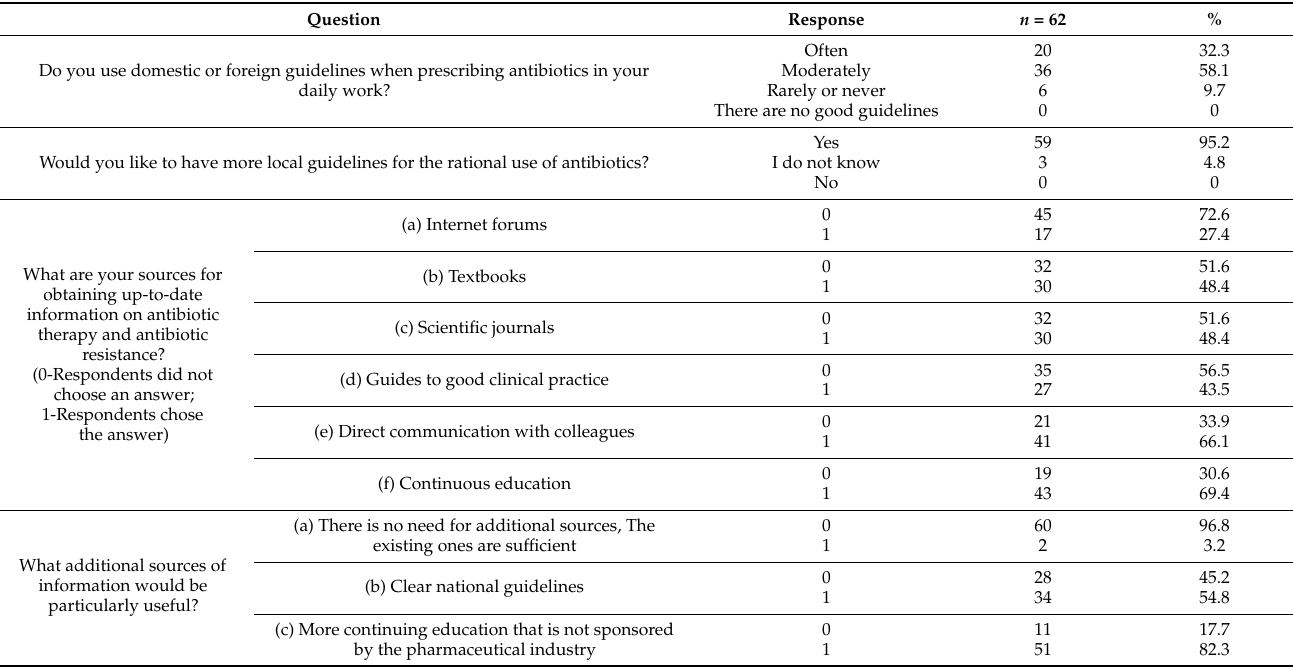
Table 5. Sources of